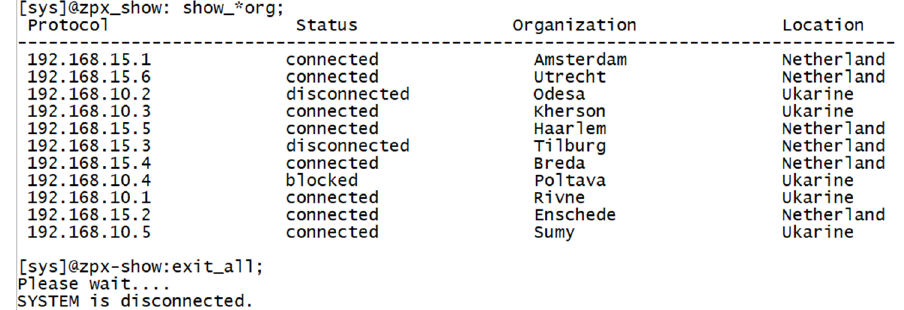
Figure 8. Details of all organizations.